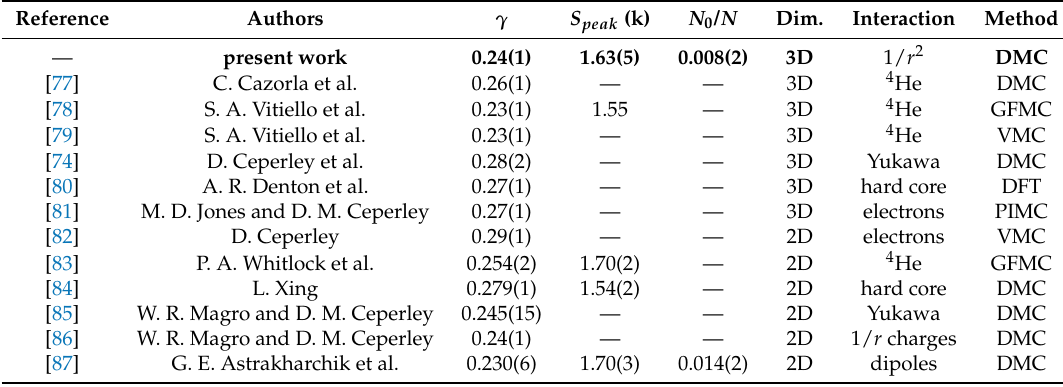
Table 1. Literature overview for the typical values of the Lindemann parameter γ (solid phase), height of the peak of the static structure factor S peak ( k ) and condensate fraction N 0 / N (gas phase) at the critical point of zero-temperature gas(liquid)-solid phase